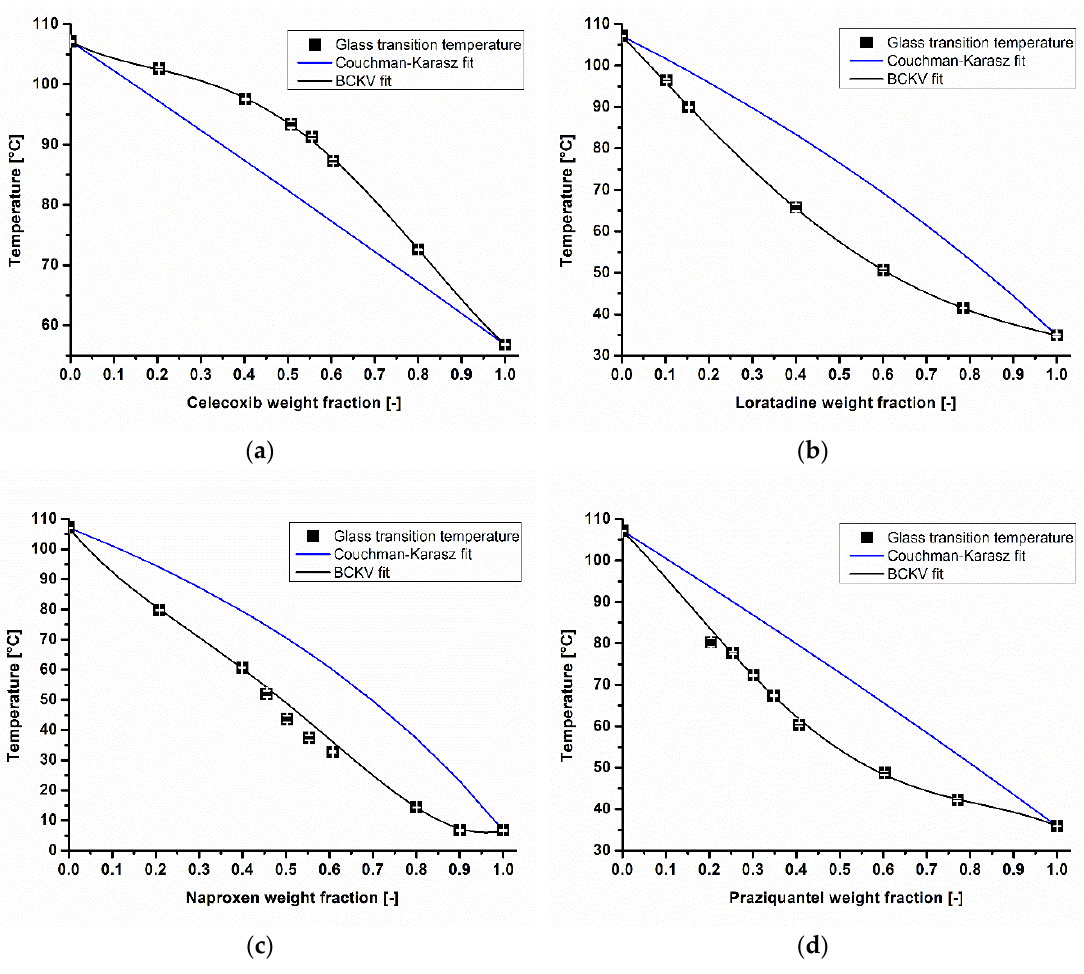
Figure 3. Determined glass transition temperatures ( ), Couchman – Karasz (CK) and Brostow Chiu Kalogeras Vassilikou-Dova (BCKV) fits of celecoxib ( a ), loratadine ( b ), naproxen ( c ), and praziquantel ( d ) in different weight fractions in copovidone.